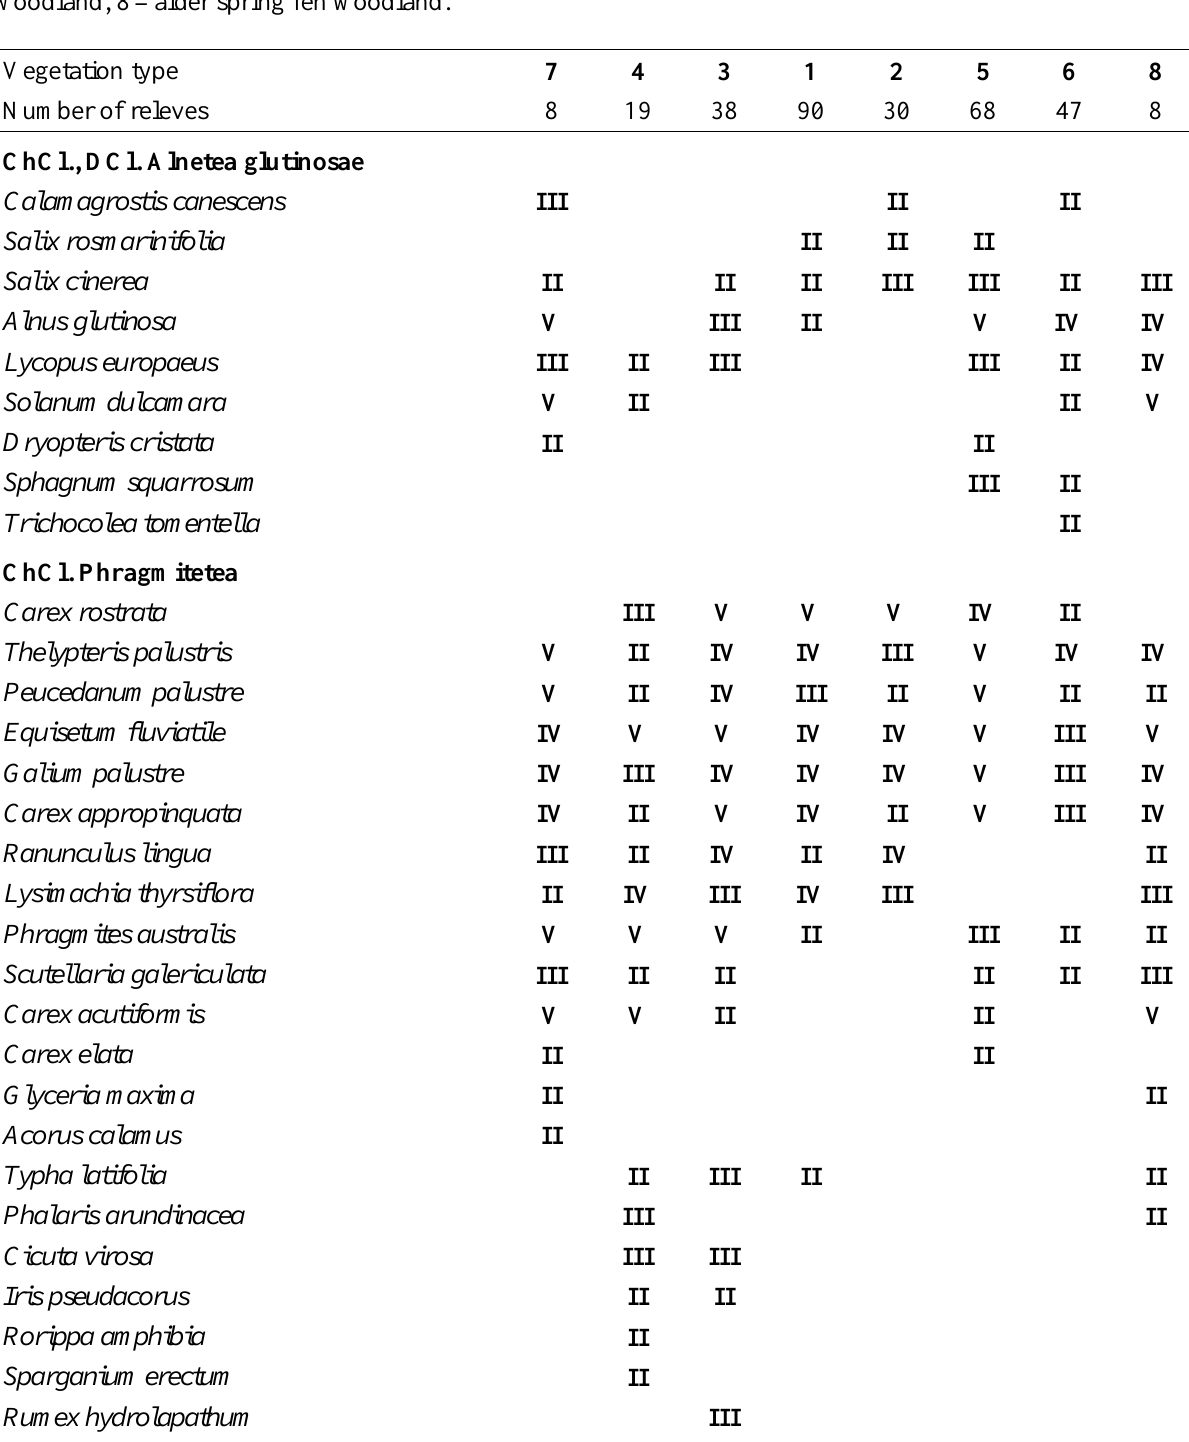
Table A1. Synoptic table for the eight vegetation types along the five transects, prepared on the basis of relevés recorded in 2006–2008. Only species with frequency category II and higher are shown. Vegetation types: 1 = brown moss - small sedge fen, 2 = Sphagnum - small sedge fen, 3 = brown moss - tall sedge fen, 4 = tall sedge - reed fen, 5 = pine - birch fen woodland and shrubland, 6 = spruce fen woodland, 7 = inundated alder woodland, 8 = alder spring fen